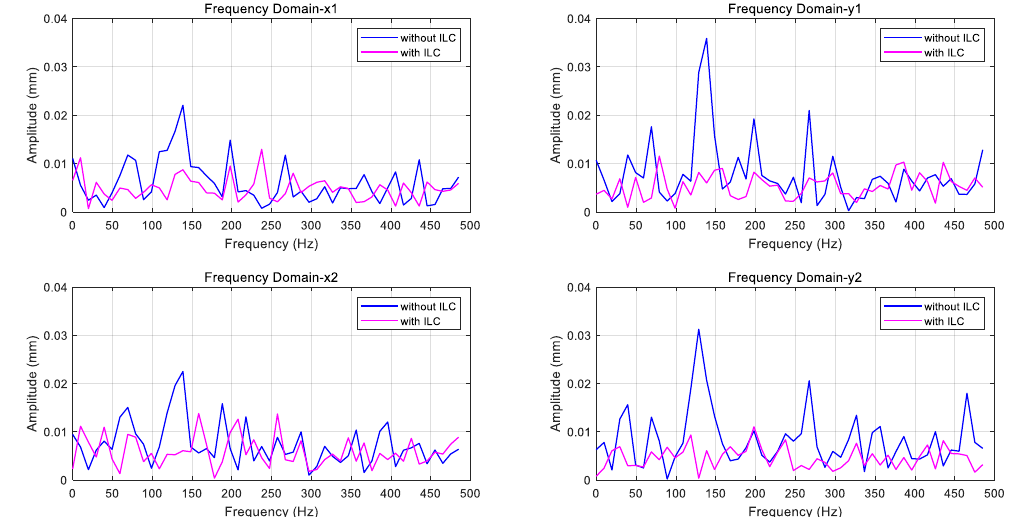
Figure 10. The vibration spectrums of the four radical directions with and without the ILC.